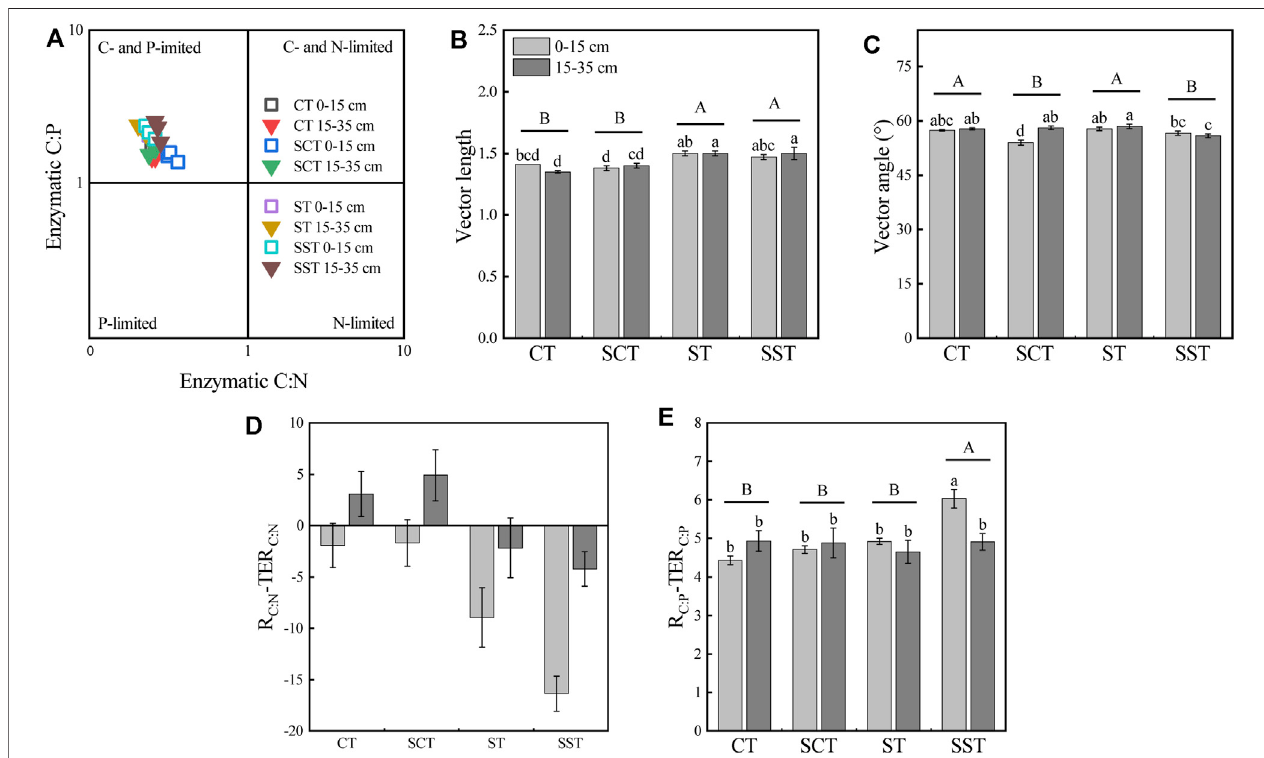
FIGURE 3 | Scatter plot of soil enzymatic stoichiometry showing the general pattern of microbial resource limitation (A) . Variation of vector length (B) , vector angle (C) , R C:N -TER C:N (D) and R C:P -TER C:P (E) among the treatments. Different capital letters represent signi fi cant differences among four different treatments. Different lowercase letters represent signi fi cant differences among four different treatments in different soil layers. See Materials and methods for abbreviation de fi nitions.